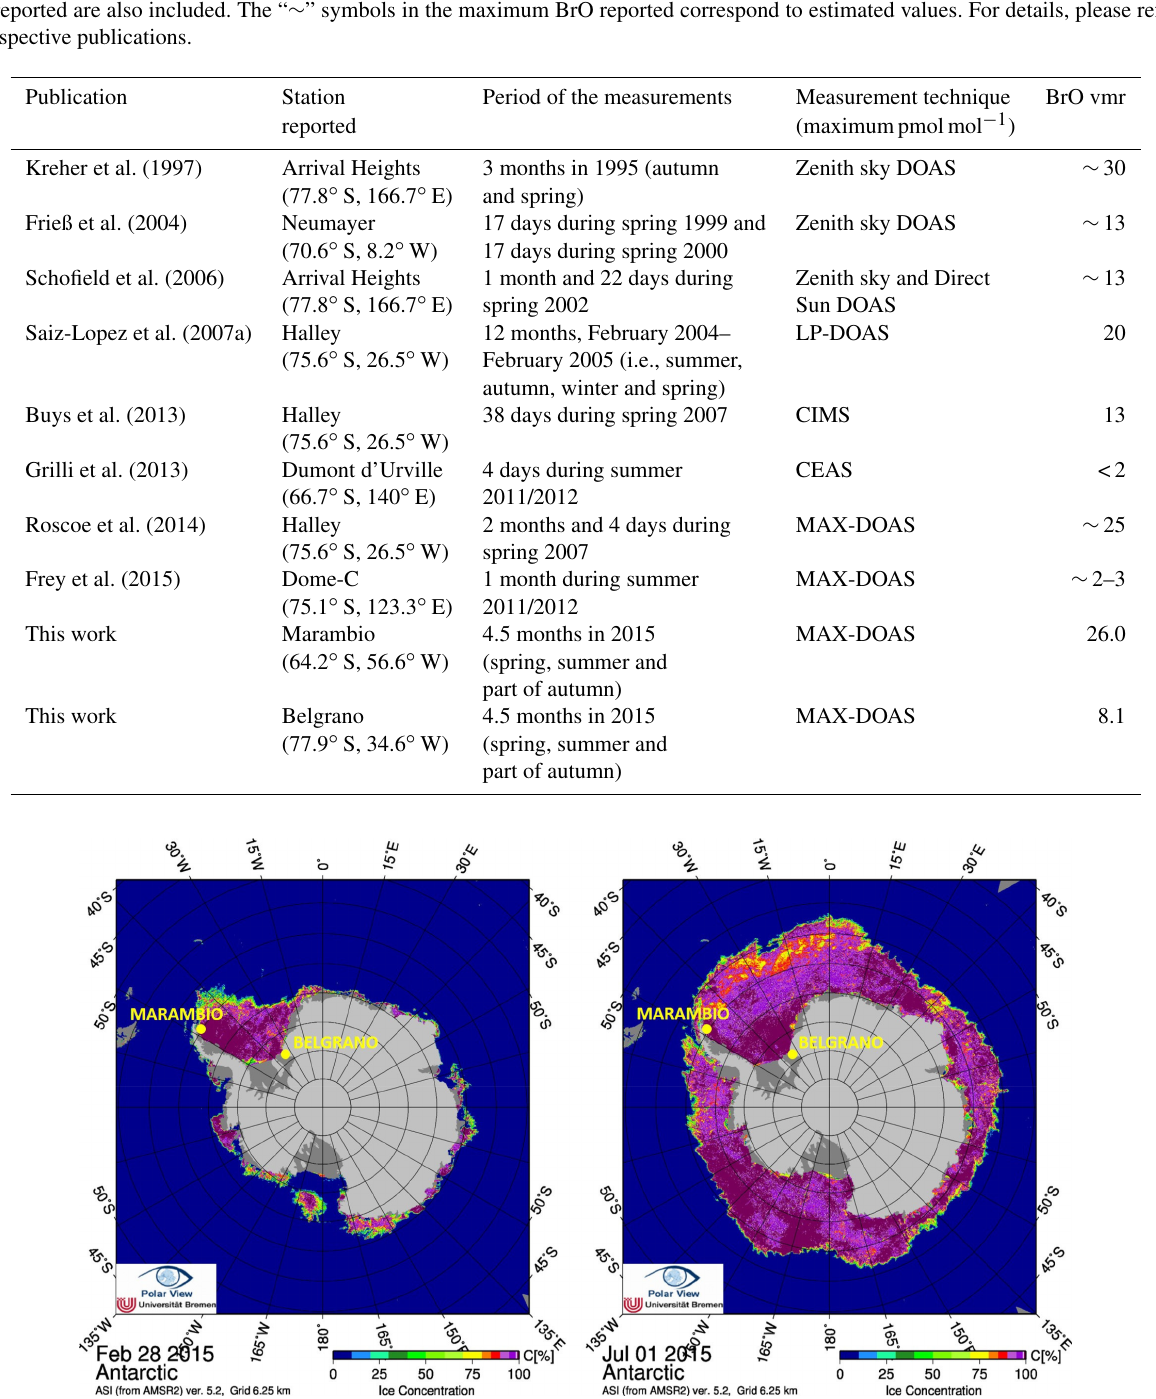
Figure 1. Sea ice concentration surrounding the two Antarctic stations. The figure shows the sea ice concentration in Antarctica at the end of the austral summer (left) and at mid-winter (right) of 2015. The sea ice maps are downloaded from https://seaice.uni-bremen.de/databrowser/ (last access: 17 November 2017) (Spreen et al., 2008). The two Antarctic stations of Marambio and Belgrano are marked in yellow in both figures. Note the variability in the sea ice mainly near